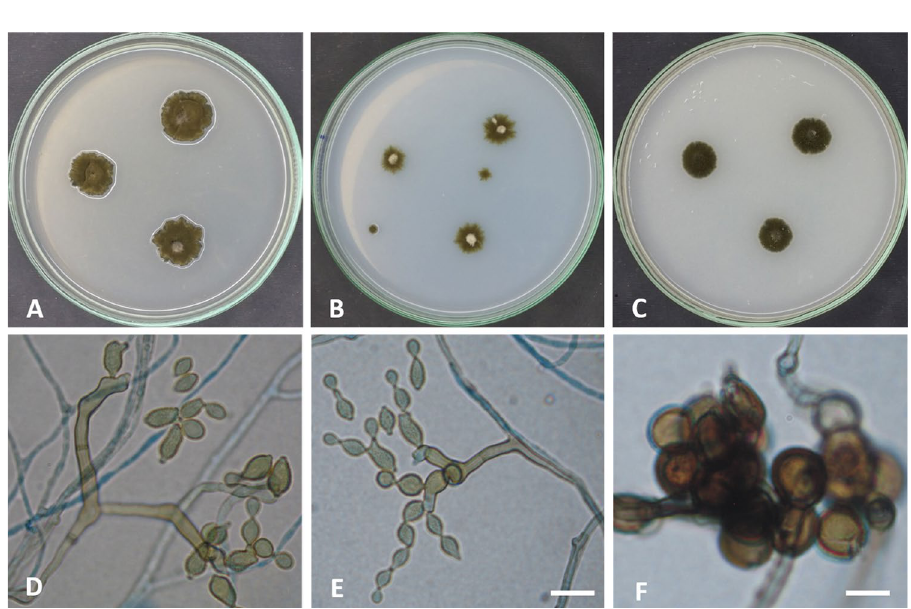
Figure 5. Cladosporium chlamydosporigenum (AUMC 11340). ( A–C ) 7-day-old colonies on PDA, SNA and OA at 25 °C. Mycelium with abundant chlamydospores. ( D–E ) Macronematous conidiophores and conidial chains. ( F ) Aggregated chlamydospores. Scale bar = 20